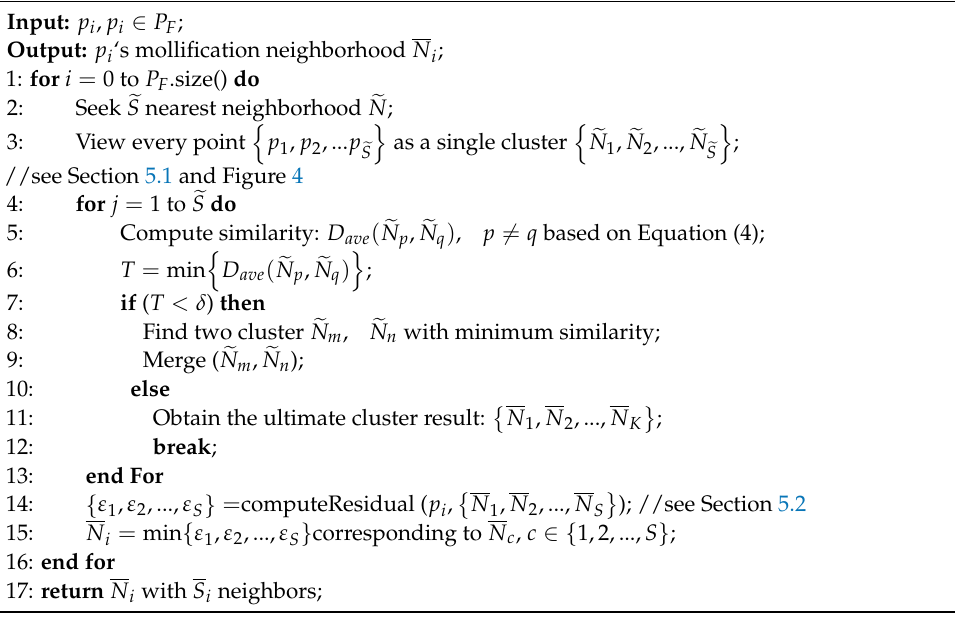
Algorithm 2 Neighborhood recognition of feature